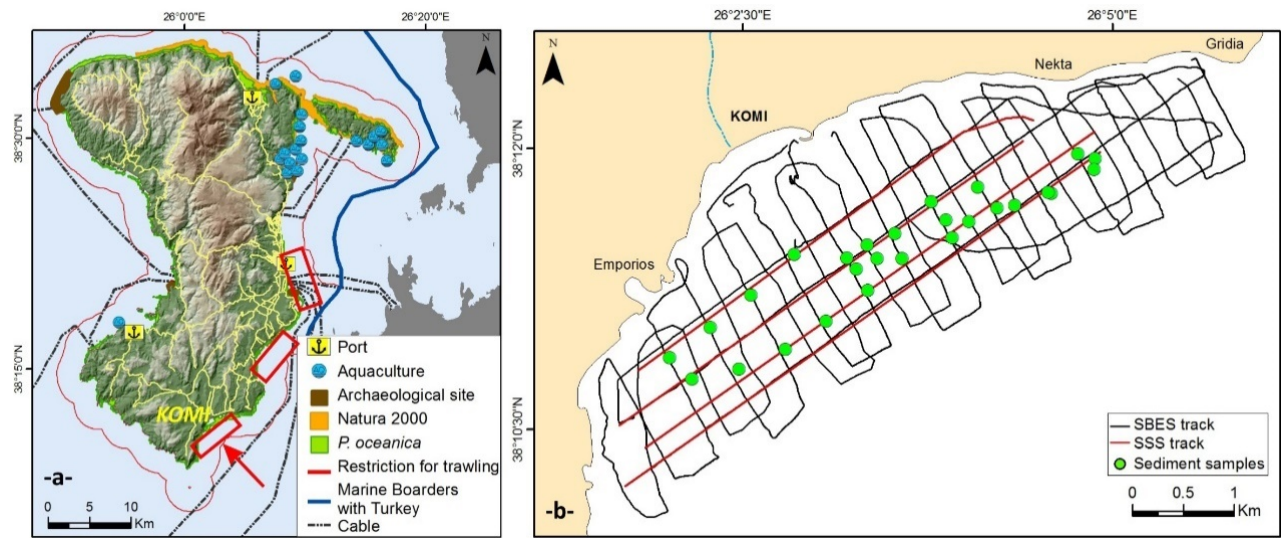
Figure 2. ( a ) Distribution of various natural and human features and marine use restrictions around Chios, and the 3 sites (red boxes) selected for MA investigations (red arrow to Komi). ( b ) SBES and SSS tracks and surficial sediment samples of the Komi MA survey.